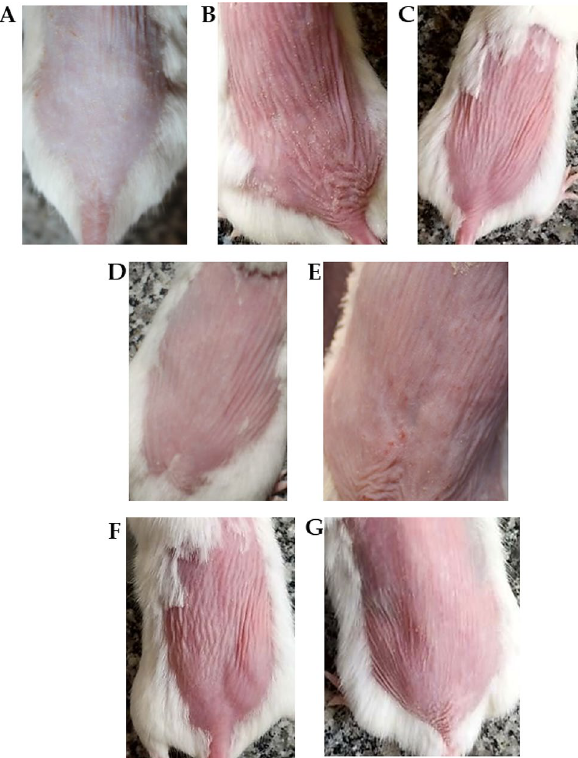
Figure 5. Photographs for the dorsal side skin of mice: ( A ) normal skin, ( B ) UV+, ( C ) Plain gel, ( D ) CEONLCS, ( E ) Corriander oil cream, ( F ) Plain cream, ( G ) Standard